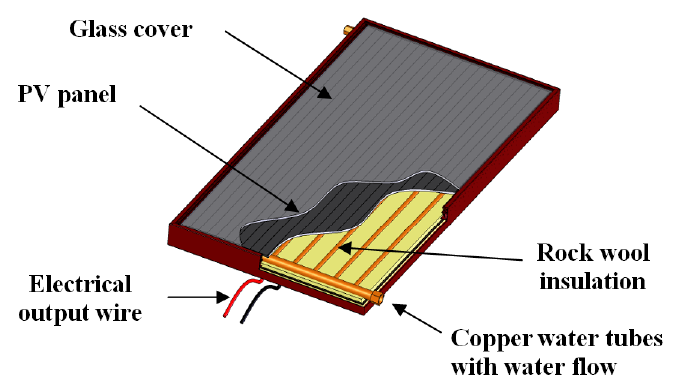
Figure 1. Configuration of PVT